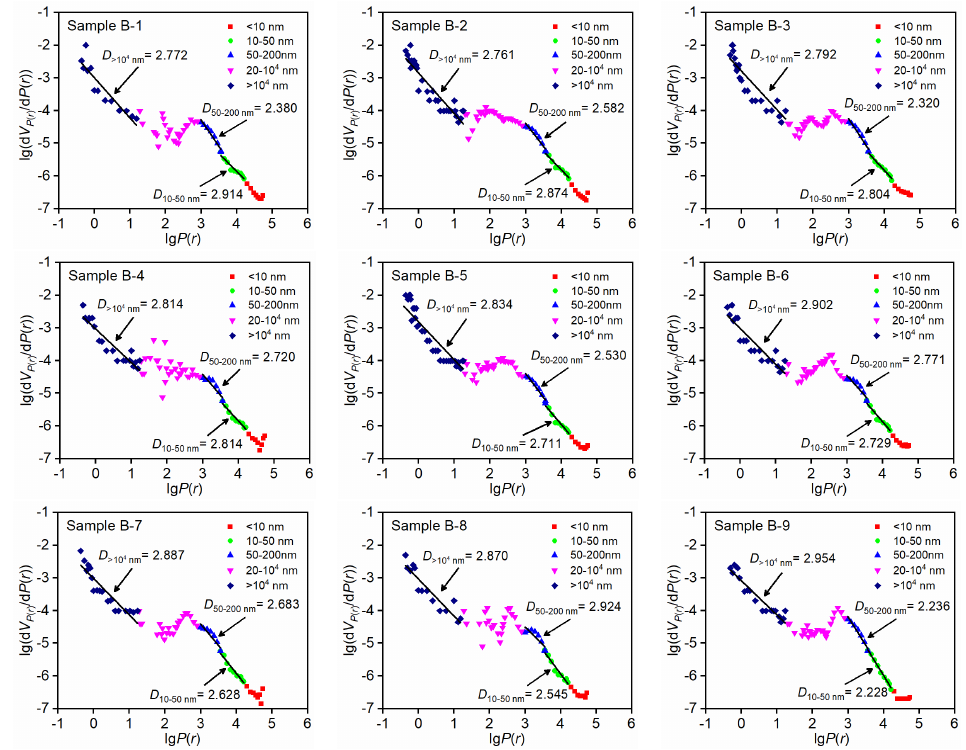
Figure 3: Logarithm plot of lg(d V P ( r ) /d P ( r ) ) and lg P ( r ) in the different pore size range under time-controlled